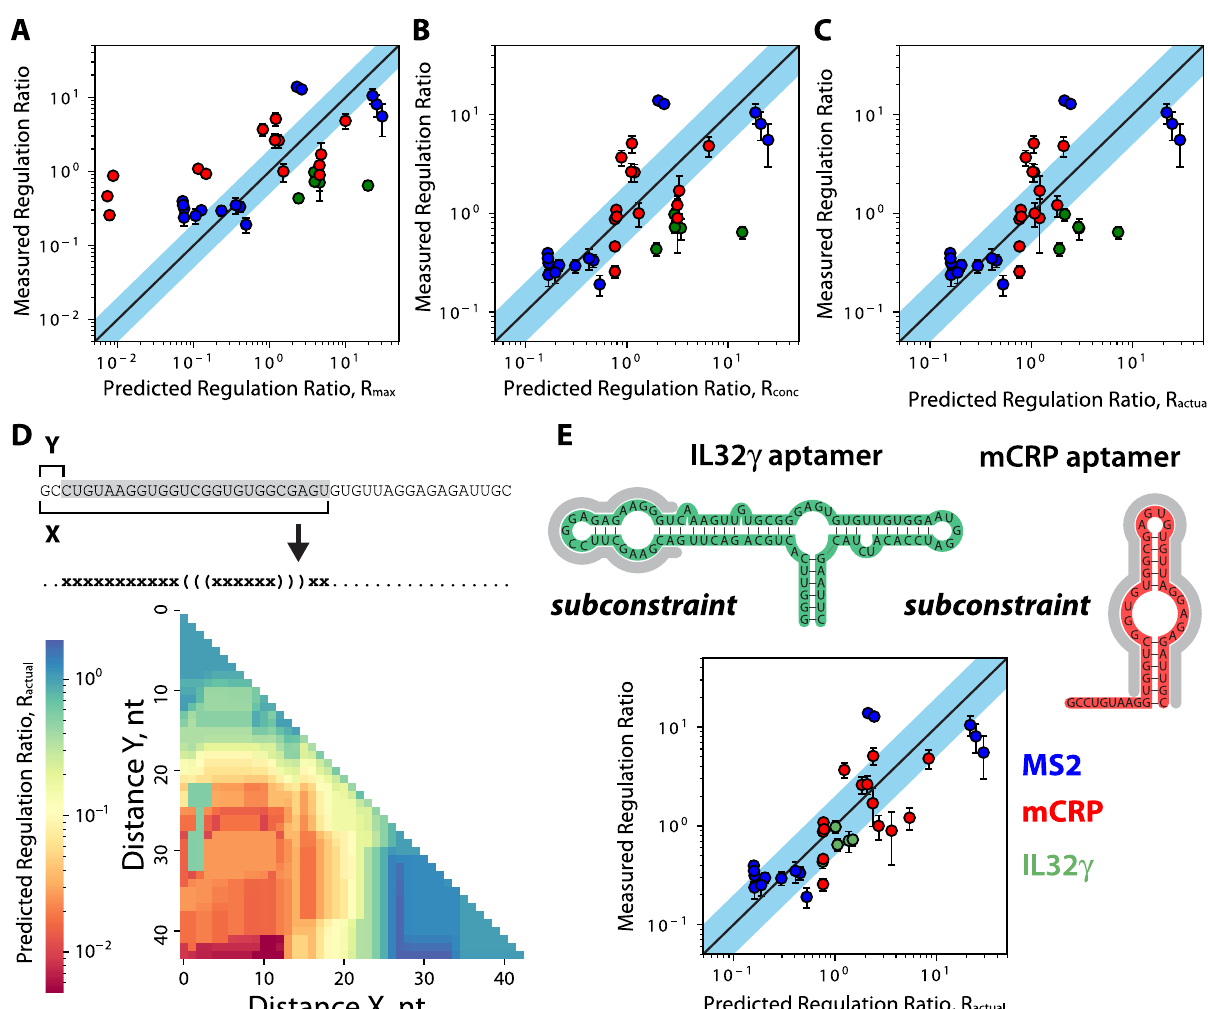
Fig. 6 | Optimizing Riboswitch Calculator predictions for in vitro protein riboswitches. Model predictions were compared to measured riboswitch regula- tion (activation or repression) ratios, utilizing three different equations that take into account additional interactions for improved accuracy. Model predictions include A themaximumpredictedregulationratio, R max , B thepredictedregulation ratiowhenconsideringtheproteinconcentration, R conc ,and C thepredictedactual regulation ratio, R actual , when considering both the protein concentration and the thermodynamics of the mRNA-protein complex. D Model predictions were